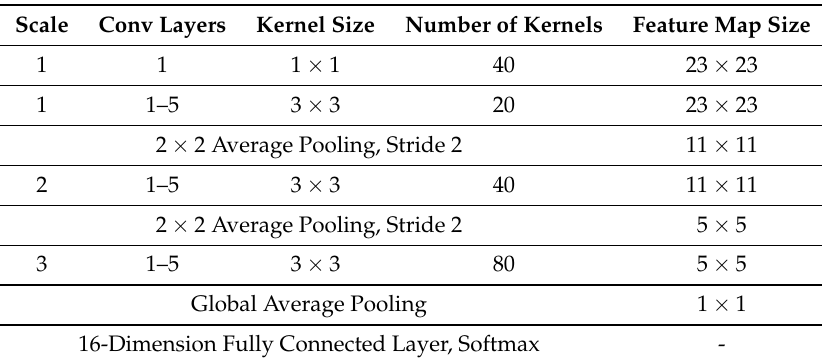
Table 2. FDMFN architecture for the Indian Pines (IP)